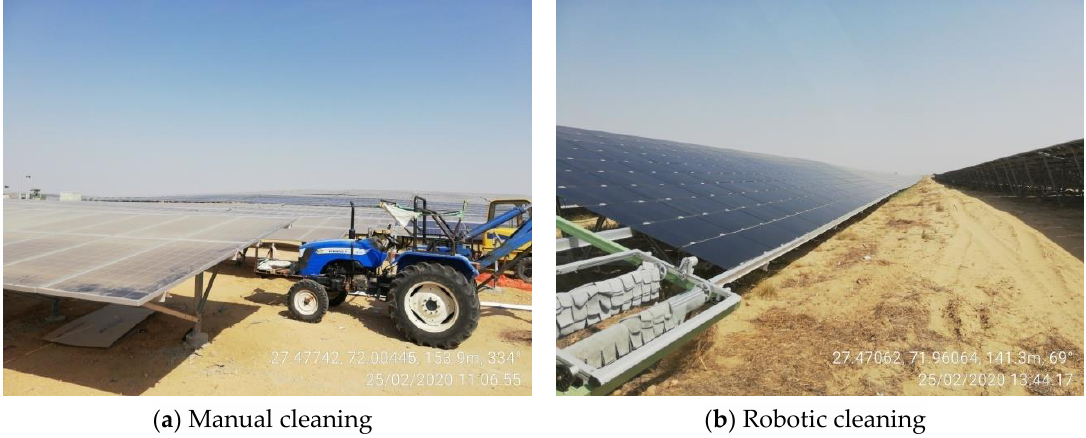
Figure 15 . ( a ) A tractor vehicle mounted with a water spray system used for manual cleaning; ( b ) Ecoppia E4 robot mounted on one of the panel rows.